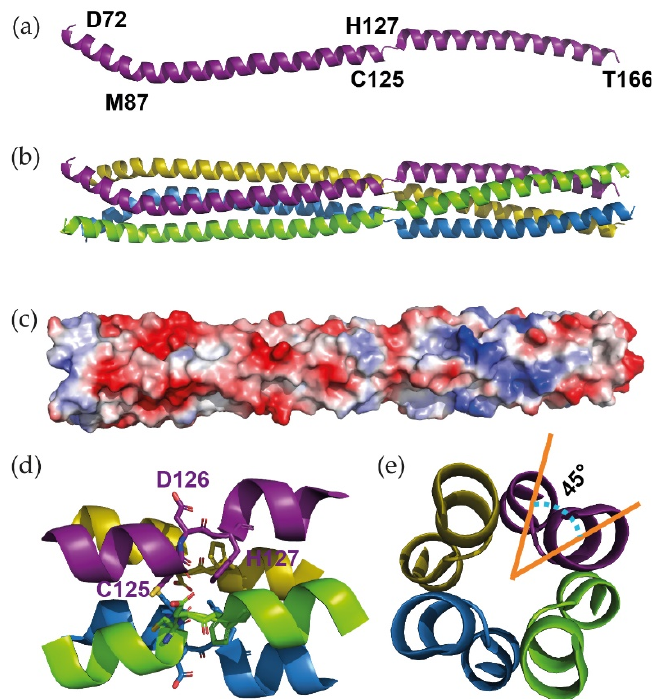
Figure 2. X-ray structure of BoDV-1 P OD . ( a ) Structure of BoDV-1 monomeric P OD as obtained in the asymmetric unit. ( b ) Structure of the tetrameric P OD after applying the inherent symmetry operations of the tetragonal space group. The four parallel monomers are coloured in purple, yellow, blue, and green, respectively. ( c ) Electrostatic surface potential of P OD . The potential scale ranges from − 5 kT/e (red) to 5 kT/e (blue); the orientation is as in ( b ). ( d ) Detail of the β -strand twist motif that separates the two α -helical coiled-coils. ( e ) Orthogonal view of the β -strand twist motif as shown in ( d ), showing the 45° rotation of the helical axis around the super helical axis.